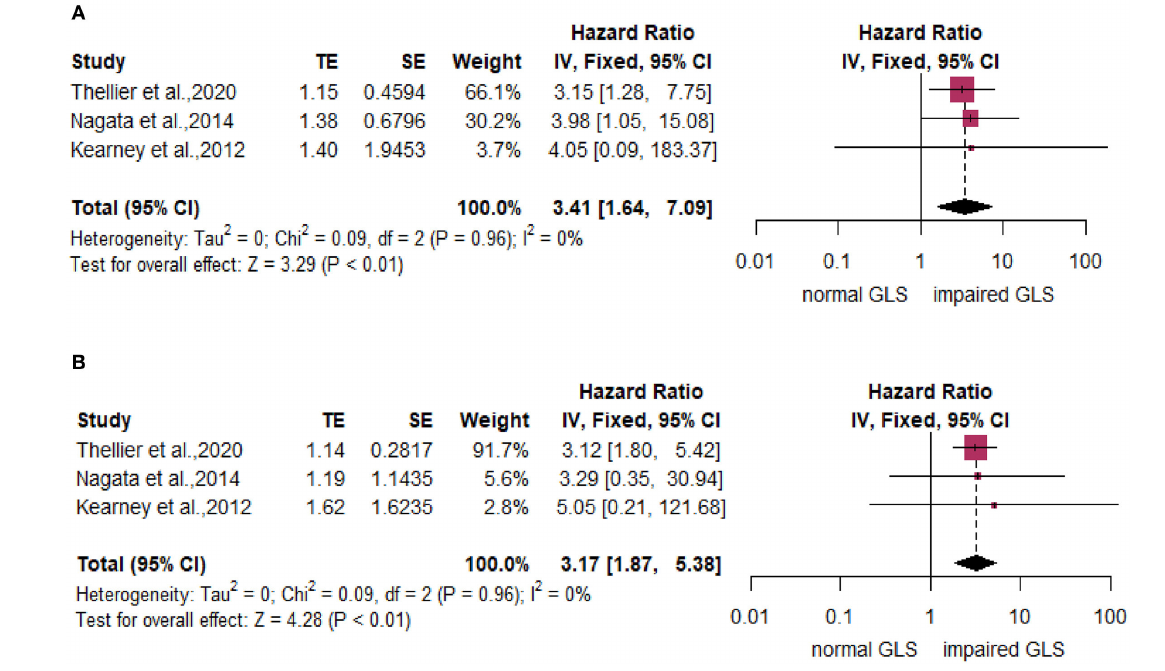
by Egger’s test ( p < 0.01) as well as Begg’s test ( p =